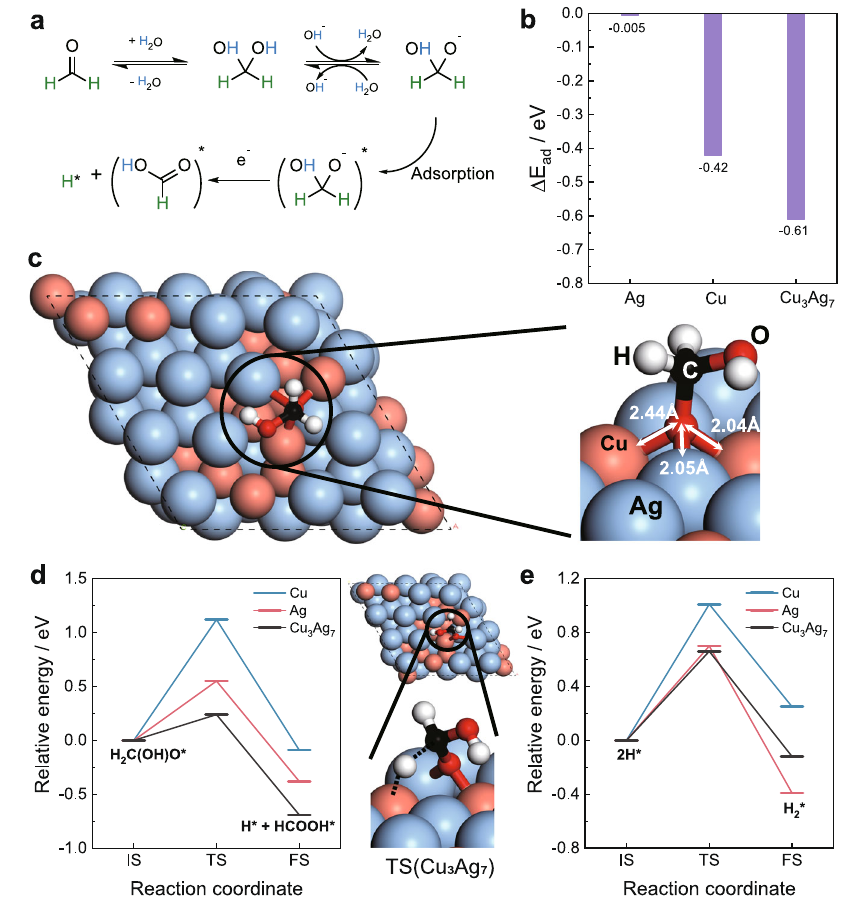
d Initial (IS),transition (TS), and fi nal (FS)states of H 2 C(OH)O dehydrogenation on